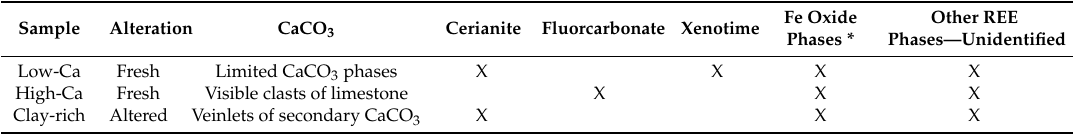
Table 5. REE-bearing phases present in the bauxite samples used in this study, identified from thin sections.